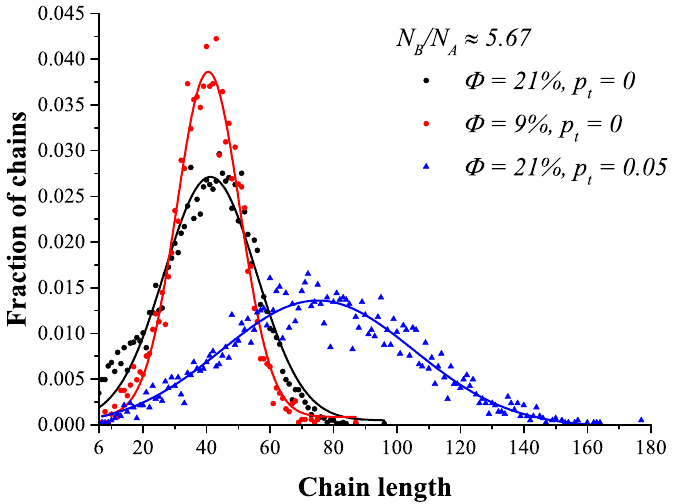
Figure 2. Molecular weight distributions of the modeled systems at a fixed chain composition ( N A = 6, N B = 34) at different polymer volume fractions Φ and termination probabilities p t at 100% conversion; 95% of the chains in the system with p t = 0.05 underwent termination. Dispersities (values of M w / M n ) are equal to 1.13, 1.07, and 1.14 for the black, red, and blue curves,